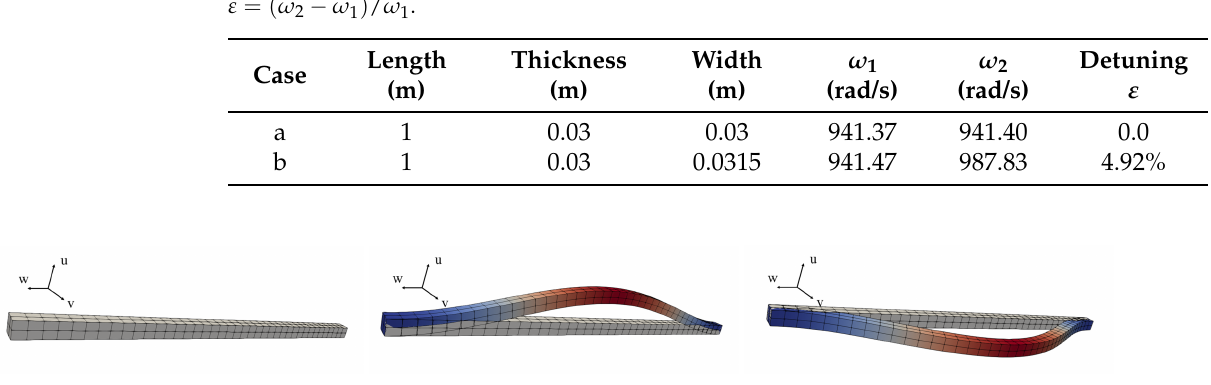
Figure 7. The beam mesh and the two polarizations of the first bending mode.